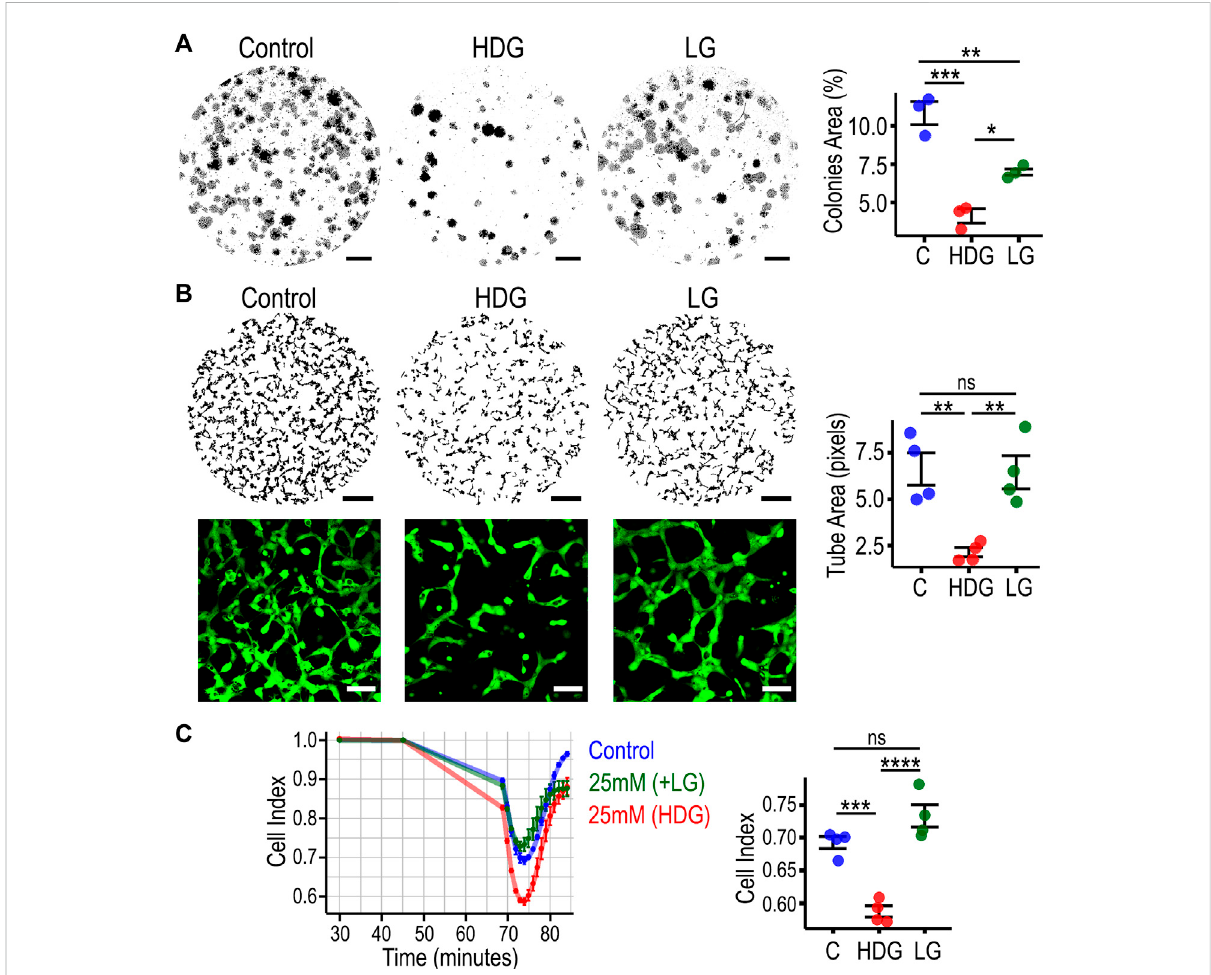
FIGURE 2 High glucose-induced premature senescent HRMECs display impairment in endothelial cell function. (A) Representative images of clonogenic assay and quanti fi cation with statistical comparison. 10X images were stitched together and the whole well of a 6-well plate is shown. Scale bar: 4 mm. (B) Representative images of 3D tube formation assay and quanti fi cation with statistical comparison. 10X images were stitched together and the whole well of a 96-well plate is shown. Scale bar: 500 µm. For 20X images, cells were stained with calcein in green. Scale bar: 100 µm. (C) Cell index traces from xCELLigence system to evaluate barrier function. VEGF was added at 45 min as the stimuli to disrupt endothelial barrier. Statistical comparison performed at 74 min as the point with highest decrease in electrical resistance. * p < 0.05, ** p < 0.01, *** p < 0.001, **** p